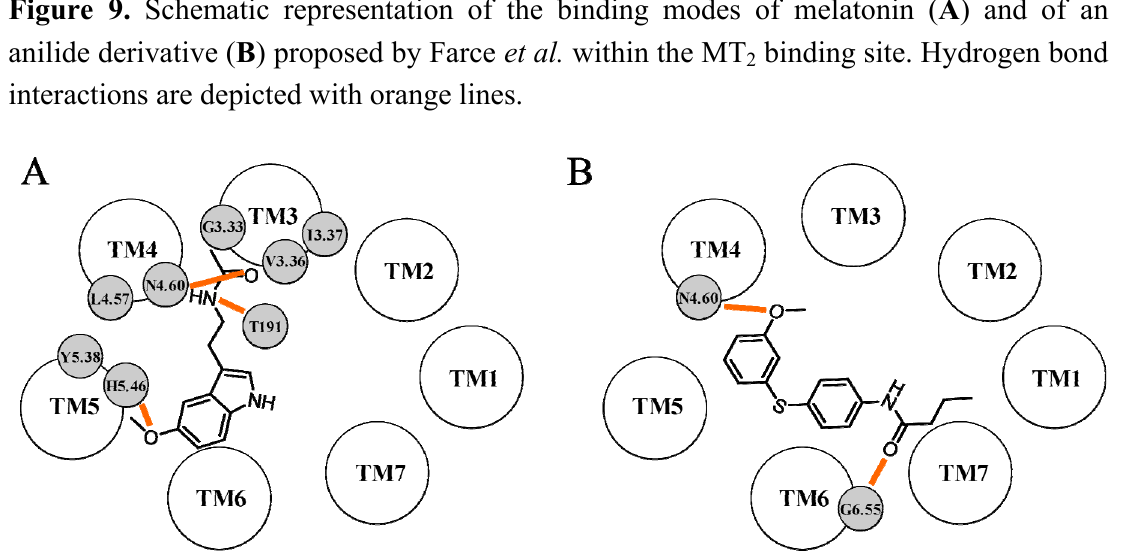
binding site. Hydrogen bond 2